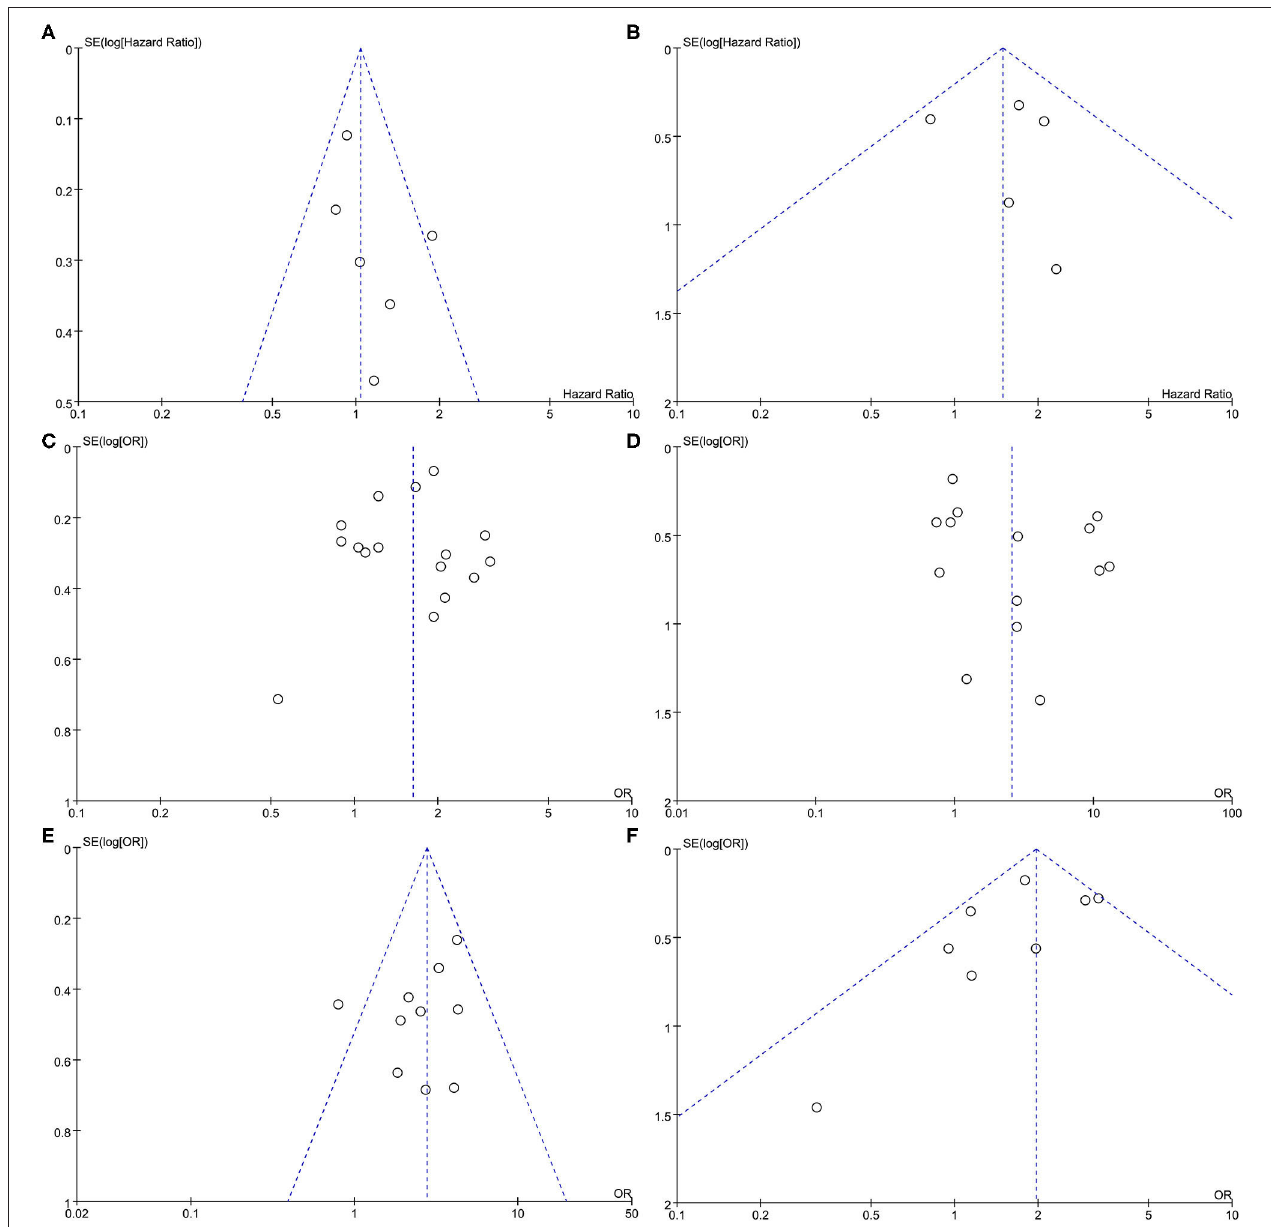
FIGURE 8 | Funnel plot comparing PCOS and non-PCOS in all outcomes. (A) All cause morality. (B) Cardiovascular death. (C) Any cardiovascular diseases. (D) Myocardial infarction. (E) Ischemic heart diseases. (F) Stroke.